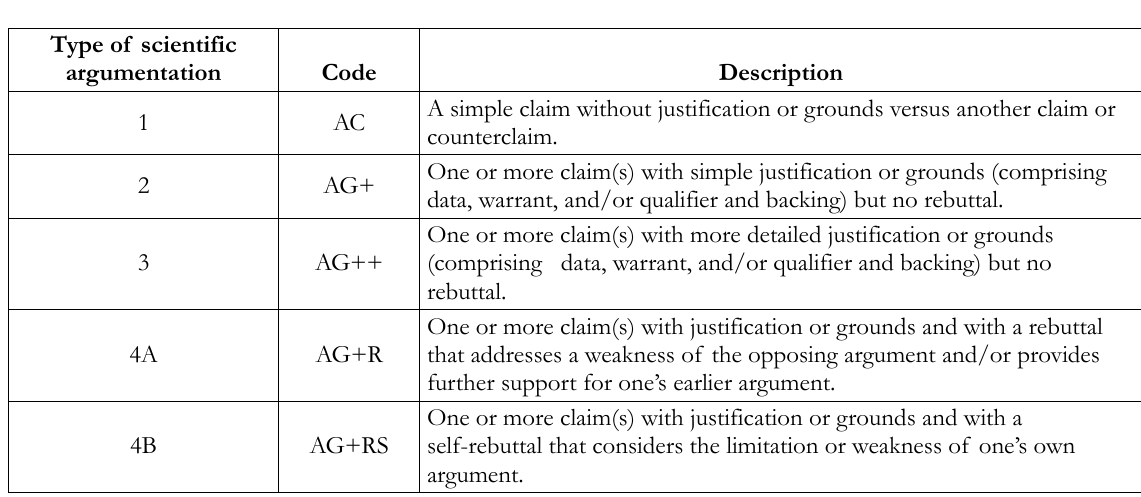
Table 1. Types of scientific argumentation (Chin & Osborne,